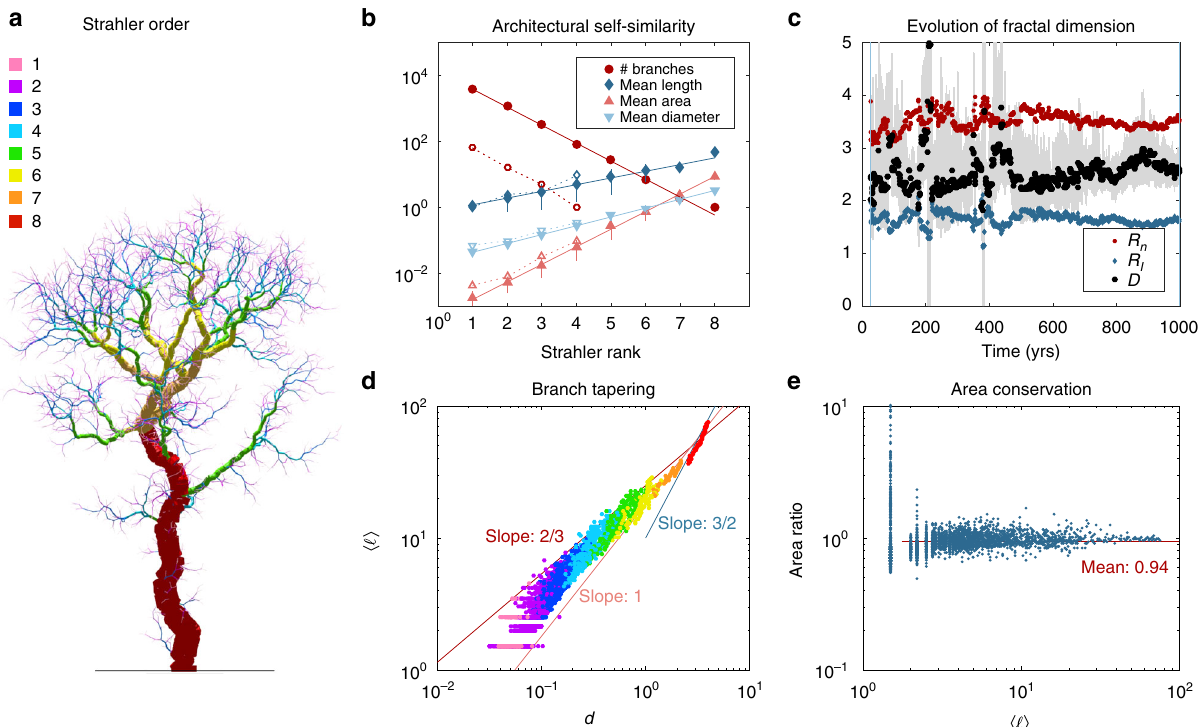
Fig. 5 Self-similarity. a Representation of the Strahler order of each branch for the tree illustrated in Fig. 4. b The number of branches, their mean length (unit L ), area (unit L 2 ) and diameter (unit L ) are plotted as a function of their Strahler order for the 999-year-old tree illustrated in Fig. 4 and in a . Error bars show standard deviations around these means. Solid lines are regression fi ts on the fi rst 7 ranks. Open symbols connected by dotted lines represent the same quantities when the tree is only 25 years old. c Evolution of the branching ratio R n , length ratio R l and fractal dimension D = ln R n /ln R l during the lifetime of the same tree. Grey bars show the 80% con fi dence interval for D . d Branch tapering is illustrated by plotting, for each segment, the average distance from the foliages, ‘ h i , as a function of the diameter d . The Strahler order of each segment is represented with the same colour code as in a . e Assessment of Leonardo ’ s rule of area conservation across branching nodes. For each node, the area ratio (i.e. the ratio between the total cross-sectional area of children segments and the parent area) is plotted as a function of the average distance ‘ h i of the parent segment from the foliages. The average area ratio measured for ‘ h i > 1 : 5 is 0.94. When restricted to ‘ h i > 10, the average is